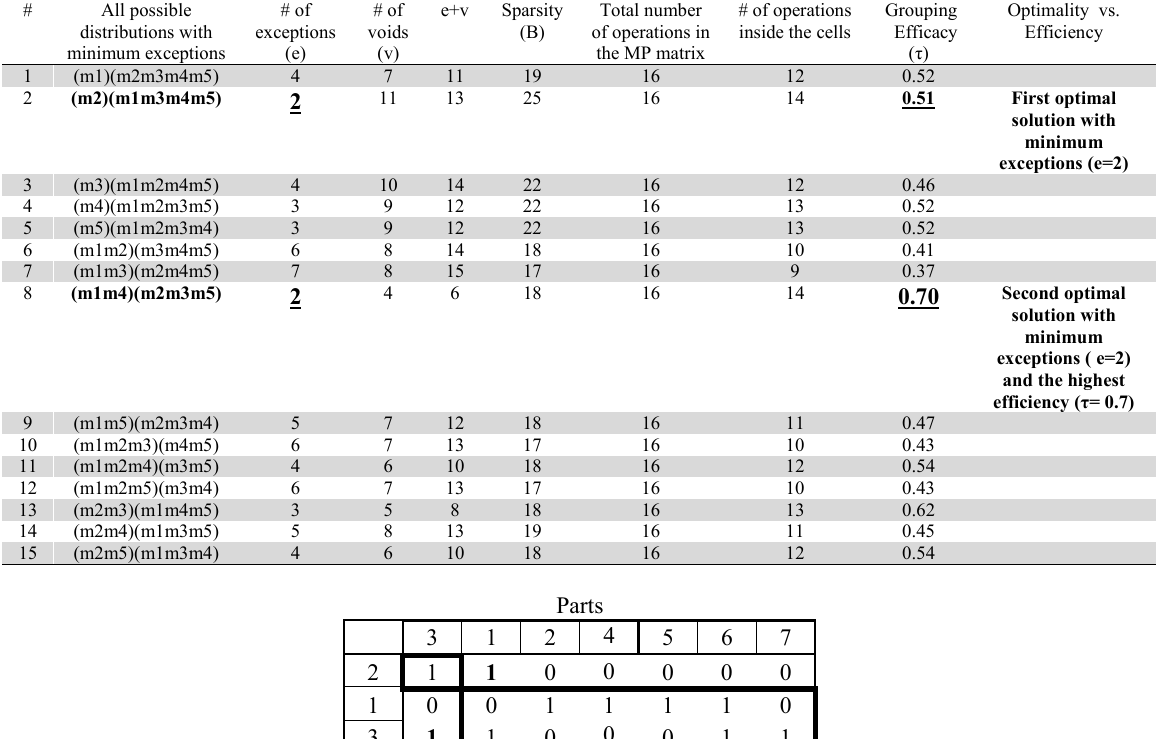
Optimality vs. Grouping Efficiency Efficacy